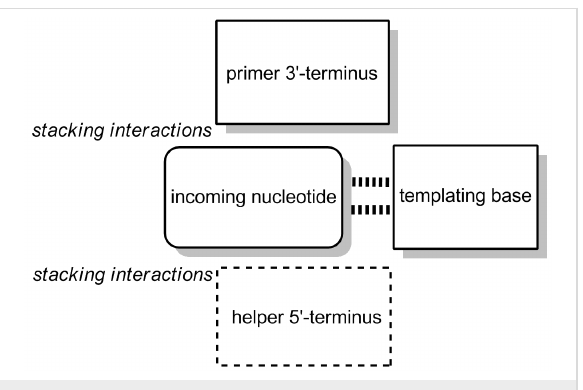
Figure 5: Interactions attracting the incoming nucleotide to the exten- sion site. Besides base pairing via hydrogen bonding to the templating base, stacking interactions with neighboring bases of primer and a possible downstream-binding helper oligonucleotide, as well as help of solvophobic effects, influence the strength of the template effect.